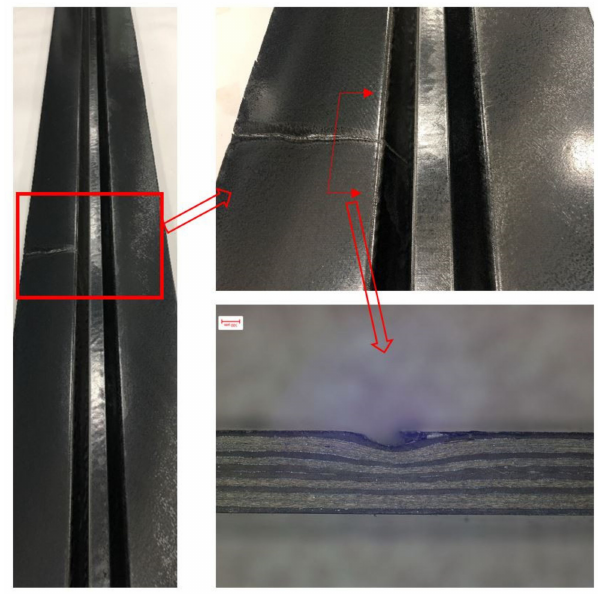
Figure 2. Fiber waviness defects found on the fabricated